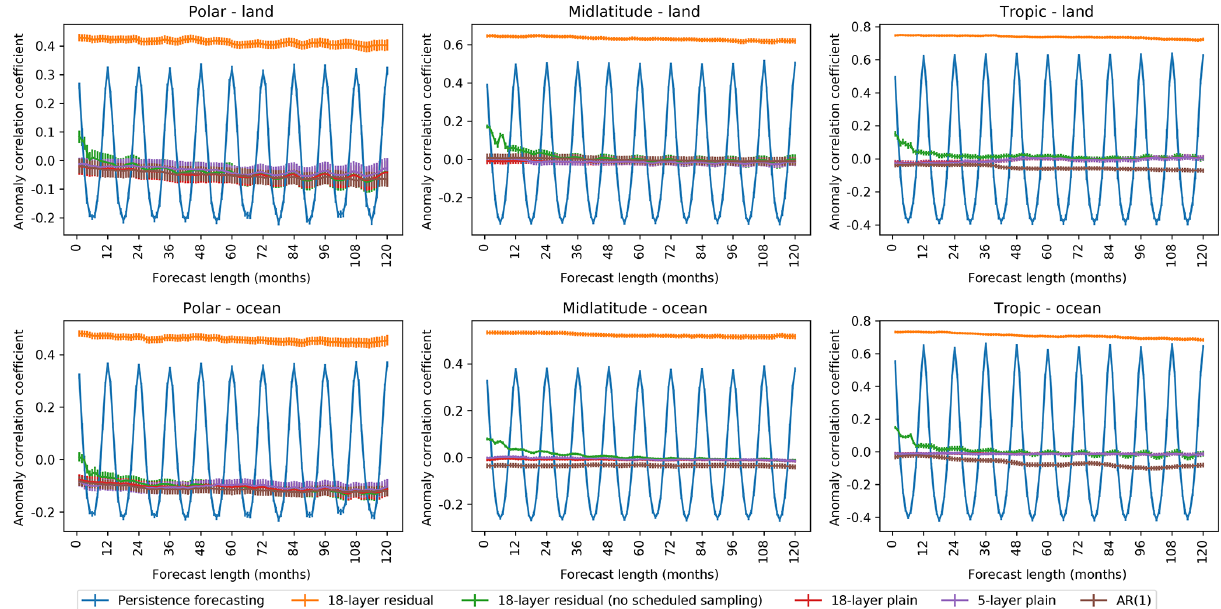
Figure 5. Anomaly correlation coefficient for decadal precipitation forecasts for six regions of interest. Both the plain and residual CNNs used a window size of 60. Vertical bars denote the standard error over all possible starting dates in the test set. As in Fig. 4, the deep residual network with scheduled sampling outperforms all models in all regions, consistently exhibiting a positive correlation with the ground truth